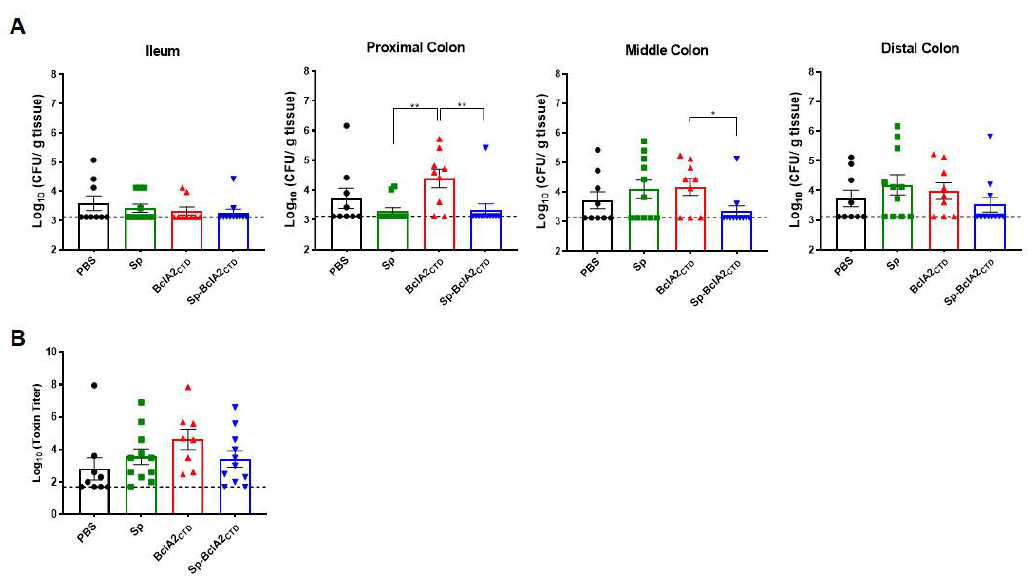
Figure 10. Challenge experiments on colonic tissues. ( A ) The loads of C. difficile spores in the ileum, proximal colon, middle colon and distal colon were evaluated upon sacrifice as log 10 CFU/g of tissue. ( B ) The cecum content toxicity was measured and represented as log 10 toxin titer. The differences between groups are evaluated with Mann–Whitney tests between groups for each tissue and one-way ANOVA Turkey’s multiple comparison tests for toxin titers. Statistical differences ( p < 0.05) are indicated by asterisks The bars are the geometric mean mean ± standard error of the mean.